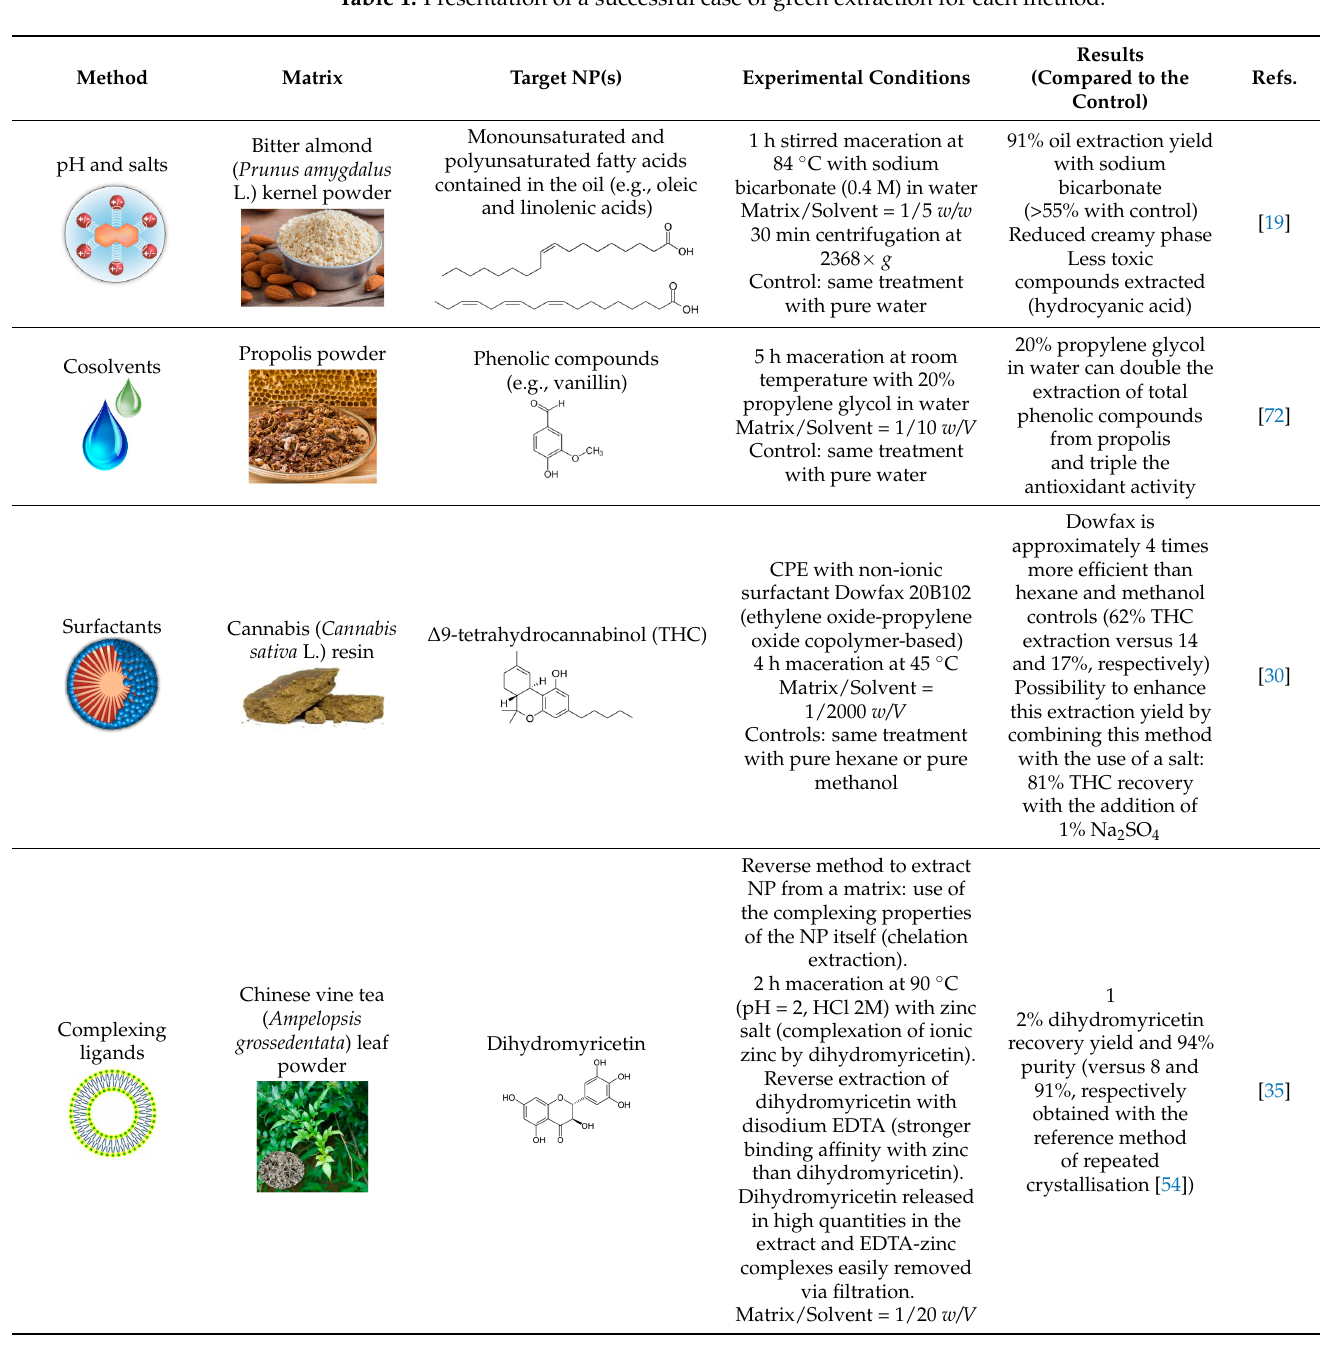
Table 1. Presentation of a successful case of green extraction for each method.